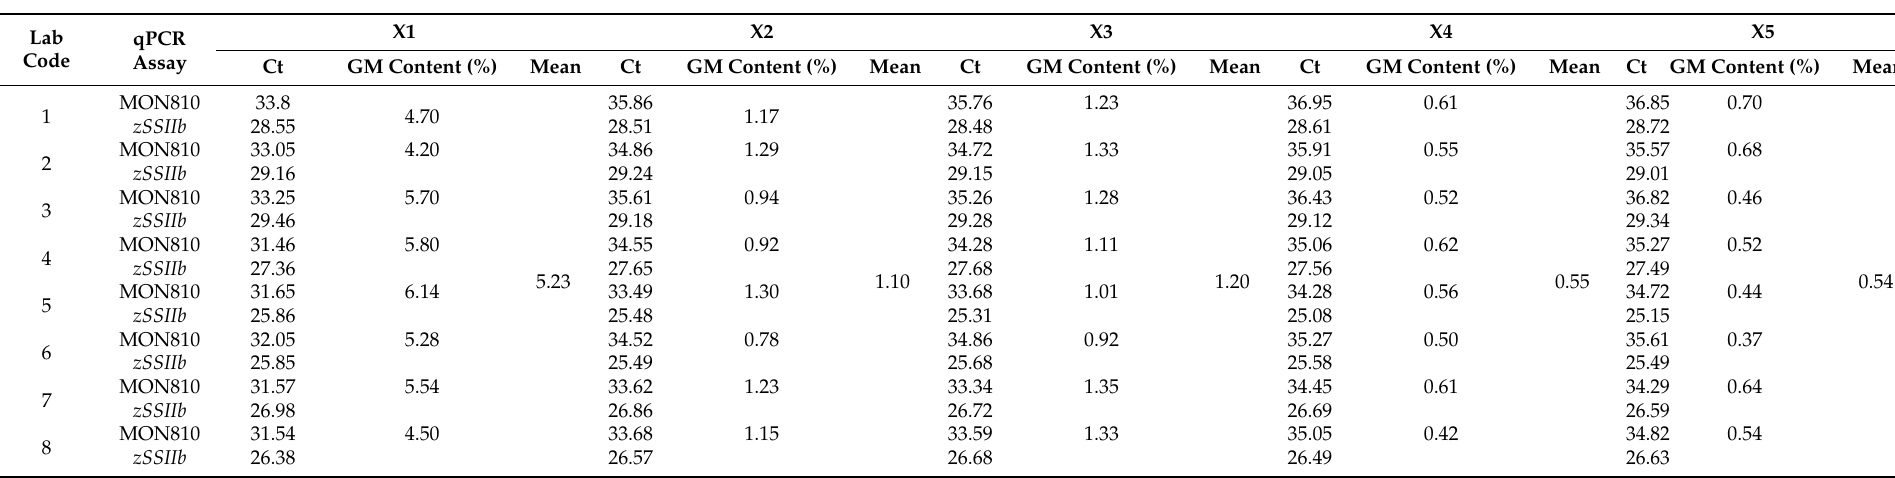
Table 3. Quantification results of blind samples from eight